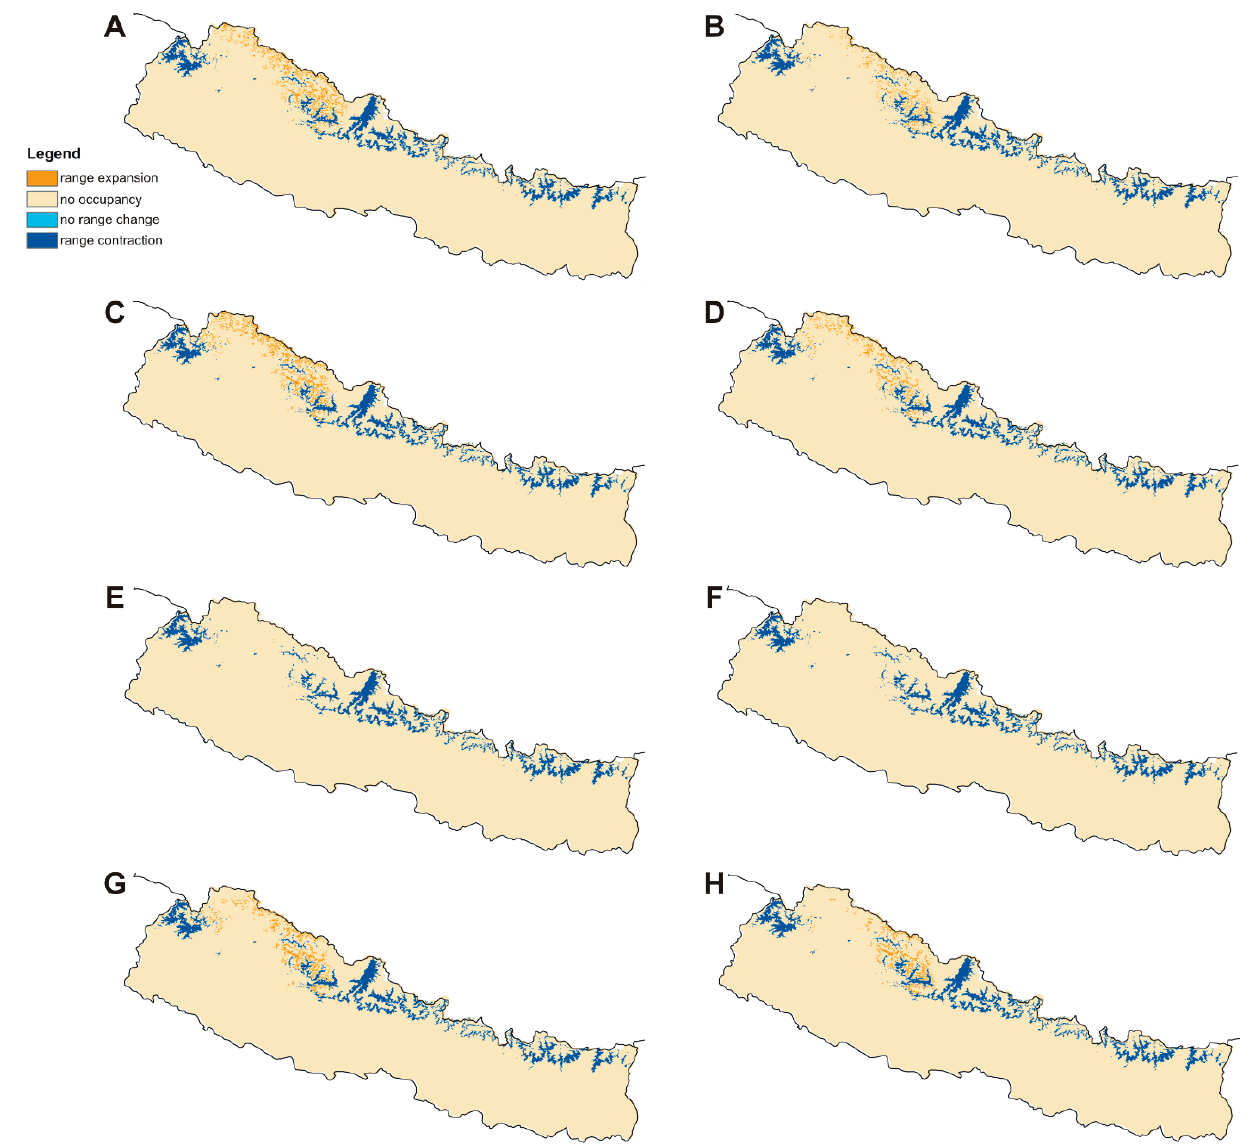
Figure 9. Changes in the distribution of suitable niches of Dactylorhiza hatagirea in 2050 according to RCP4.5 ( A , C , E , G ) and RCP8.5 ( B , D , F , H ) climate change scenarios. ( A , B ), BCC-CSM1-1 model; ( C , D ), CCSM4 model; ( E , F ), HadGEM2-ES model; ( G , H ), MIROC5 model.